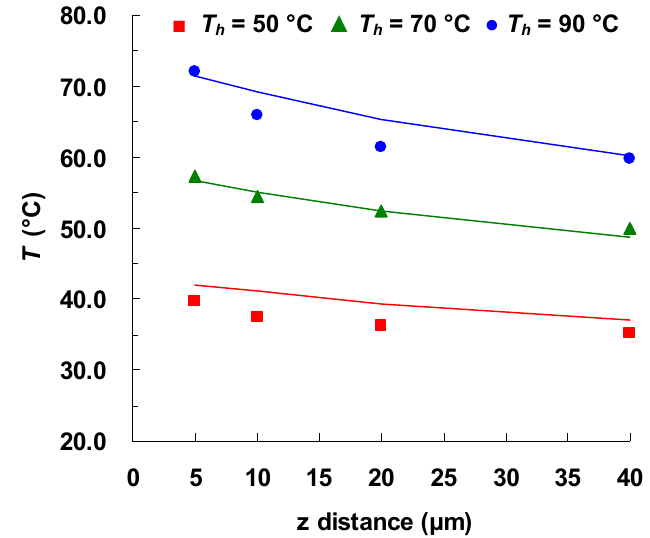
Figure 6. Measured and calculated steady-state temperature profiles in the vicinity of the microheater surface.